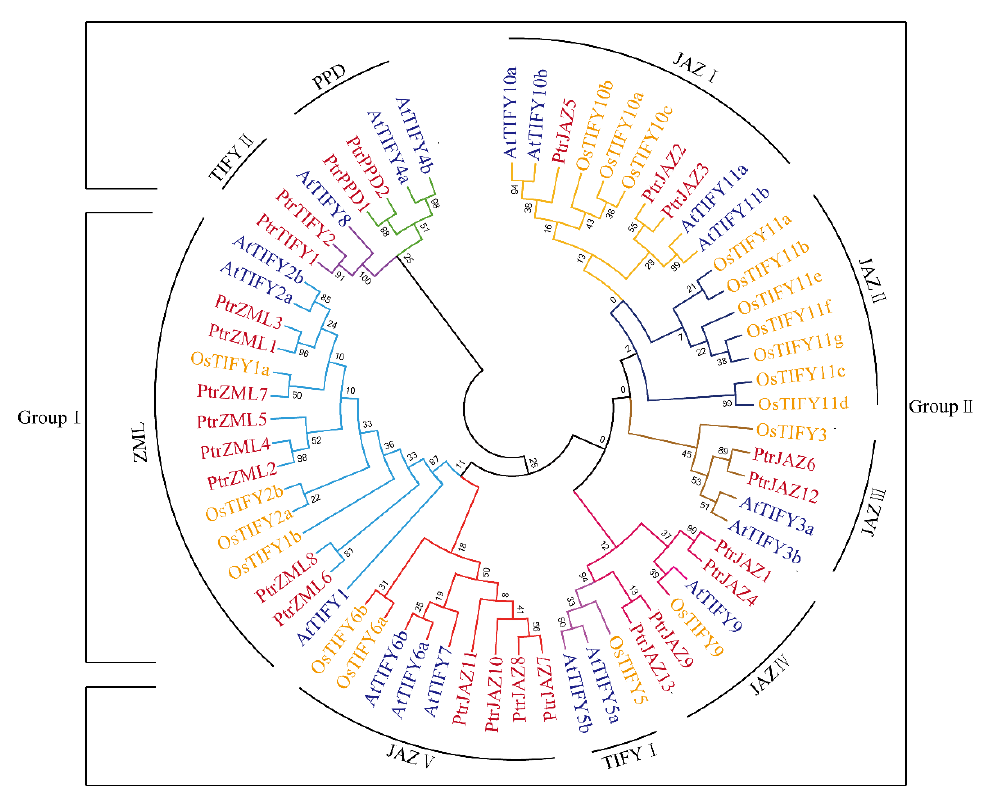
Figure 1. Phylogenetic analysis of the TIFY family members from P. trichocarpa , O. sativa , and Arabidopsis . The phylogenetic trees were constructed using the neighbor-joining (NJ) method of MEGA7 with 1000 bootstrap replicates. For Group Ⅰ and Group Ⅱ， Group Ⅰ contained the C2C2-GATA (CX2CX20CX2C) conservative domain, which was absent in Group Ⅱ . Each clade was represented by different color lines. The naming approach of each clade was following a previous study [34]. The explanation of group I and II of Figure 1 was added in the Figure 1 legend which was highlighted in red font and yellow background